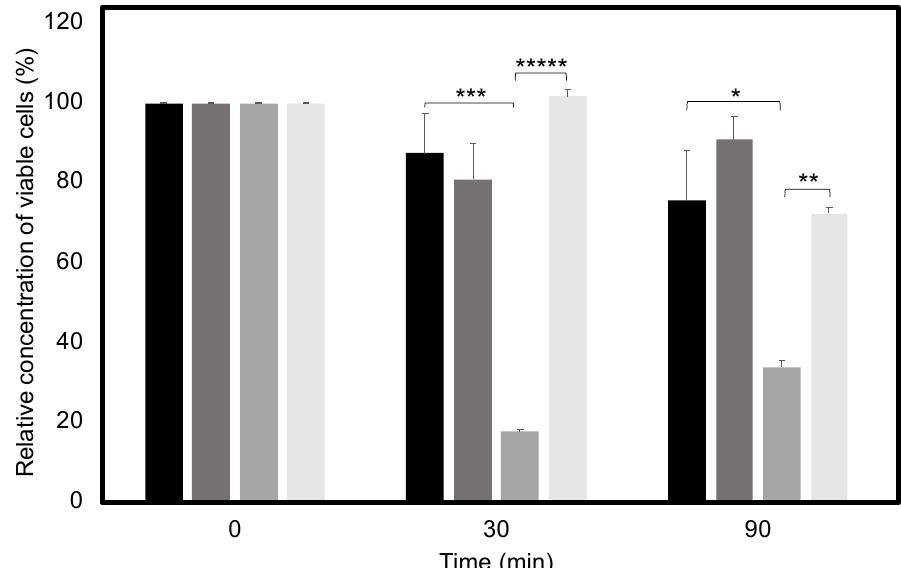
Figure 2. CgTpo4 is a determinant of histatin-5 resistance. Relative concentration of viable cells of wild-type C. glabrata KUE100, harboring the pGREG576 cloning vector (black), or the pGREG576_MTI_ CgTPO4 expression plasmid (dark grey) and the derived ∆cgtpo4 deletion mutant, harboring the cloning vector pGREG576 (grey), or the expression plasmid pGREG576_MTI_ CgTPO4 (light grey), in the presence of 35 µ M of histatin-5. The average percentage of survival, obtained from at least three independent experiments, is indicated by the black lines, with standard deviation being represented by error bars. * p < 0.05, ** p < 0.01, *** p < 0.001, and ***** p < 0.00001.